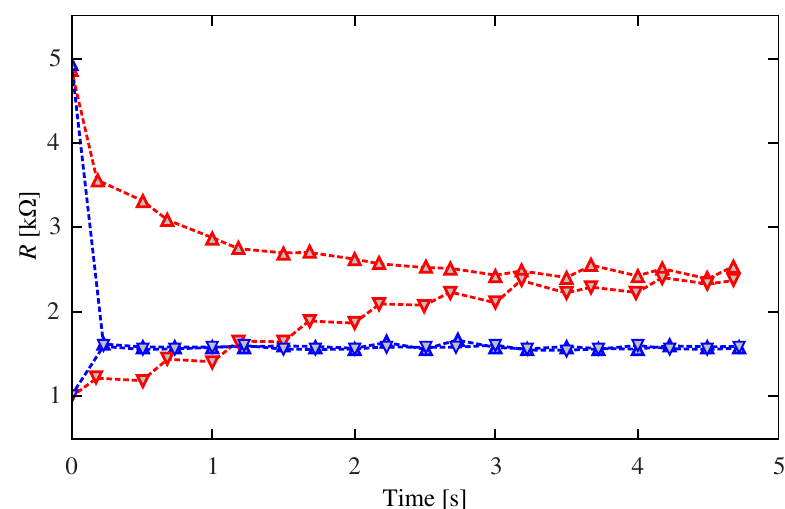
Figure 7. Behavior of the resistance. Initial conditions are indicated by the upside (= R off ) and downside (= R on ) triangles. Red and blue colors stand for ∆ t = 5 ms and ∆ t = 50 ms, respectively. All experimental parameters were as in Figure 5 except that τ 0 = 5 s.